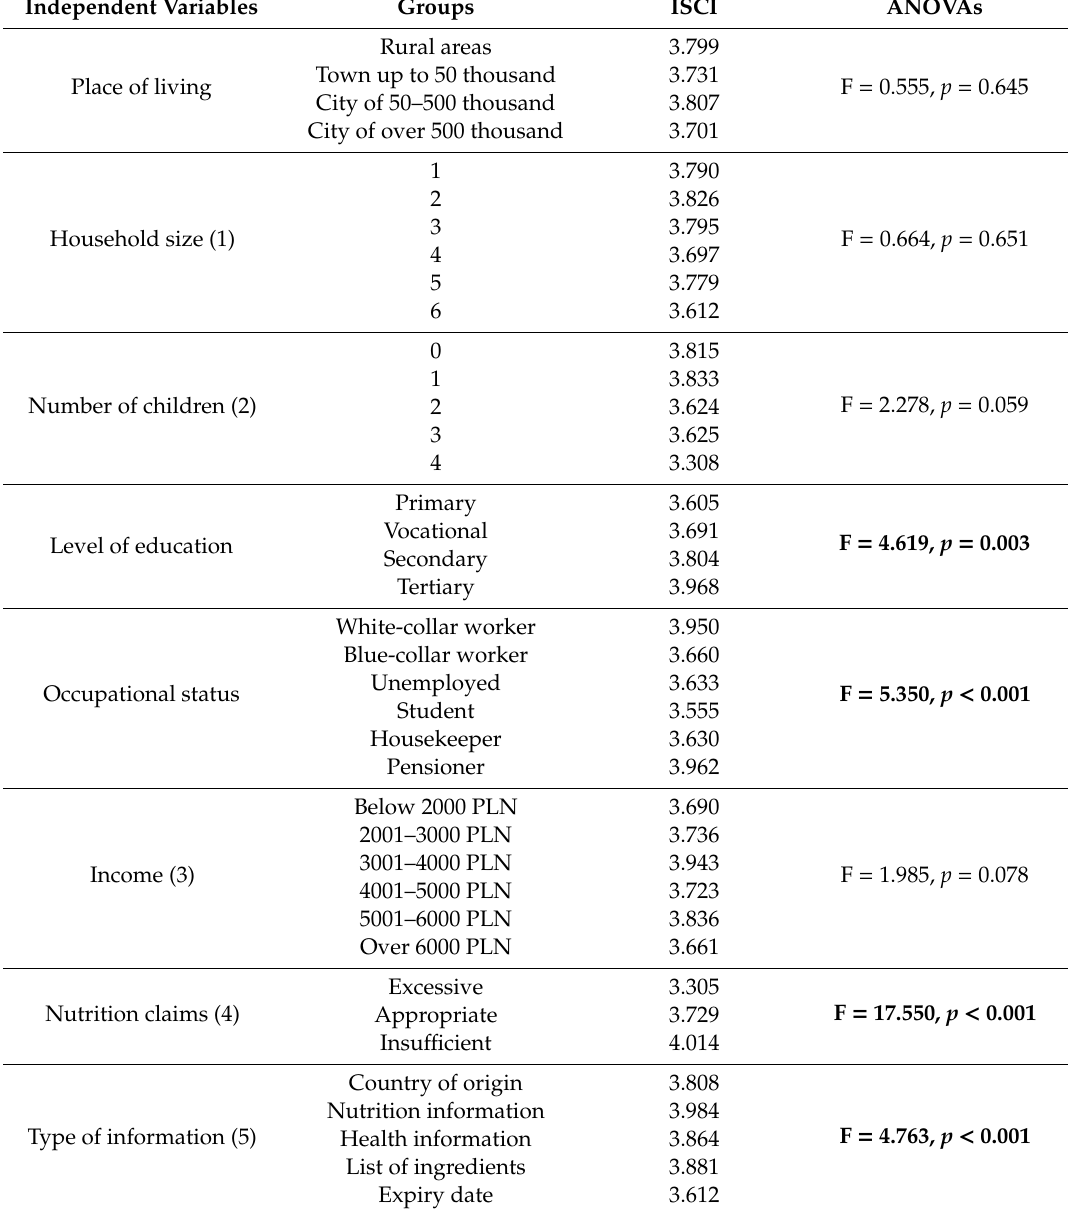
Table 2. The importance attached to salt content information on food packaging by selected characteristics of respondents (analyses of